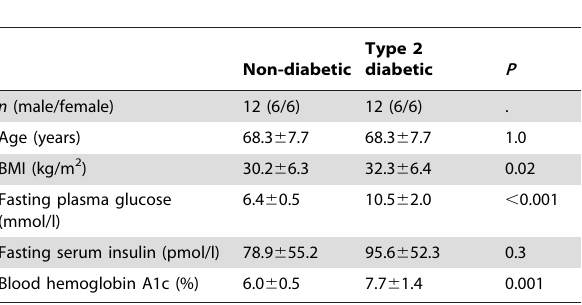
Table 1. Characteristics of monozygotic twins discordant for type 2